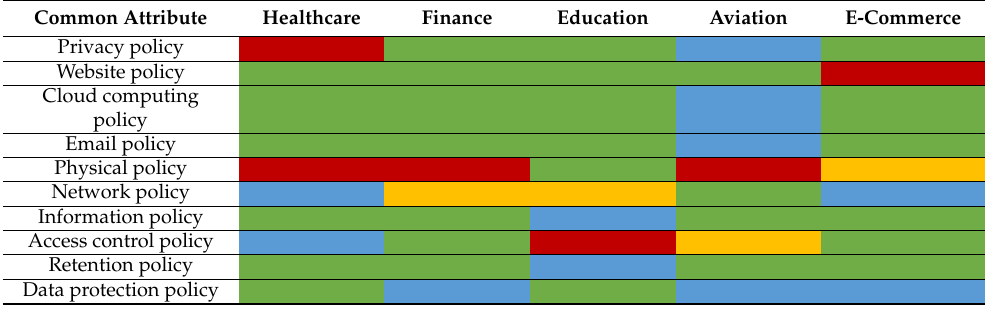
Table 1. Comparison matrix of common CS aspects for different enterprises (Red = Very High (VH), Green = High (H), Blue = Average (AVG), Yellow = Low (L)).